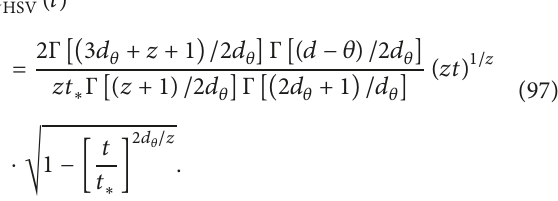
A simple calculation then shows that the entanglement velo- city is equal